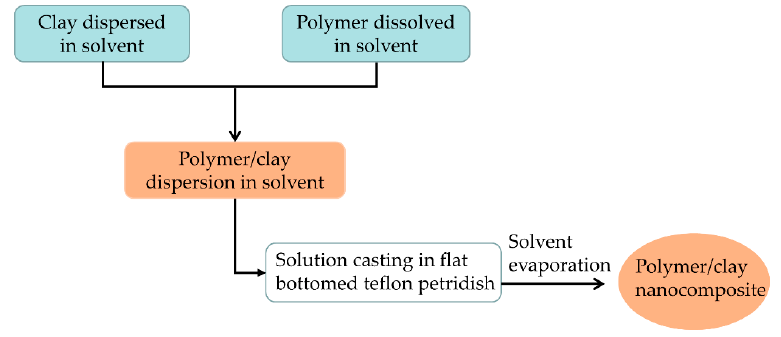
Figure 2. Solution ‐ blending method scheme. Figure 2. Solution-blending method